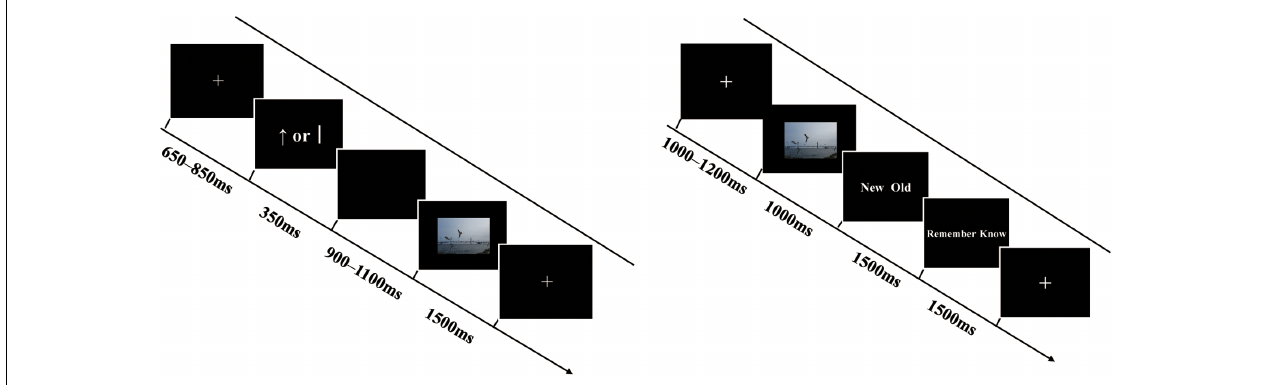
FIGURE 1 | Schematic representations of a trial in the study phase (the left) and retrieval phase (the right). See text for details. The example picture resembles those in the experiment but it is not part of the CAPS.